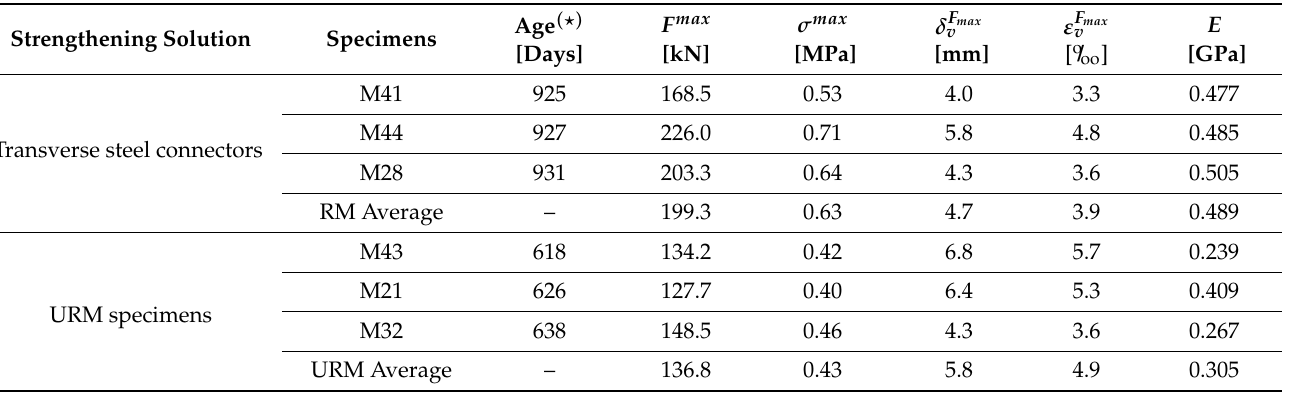
Table 1. Experimental results obtained in axial compression (monotonic tests) on specimens strength- ened by transverse confinement (M41, M44, and M28) and the URM specimens (M43, M21, and M32)